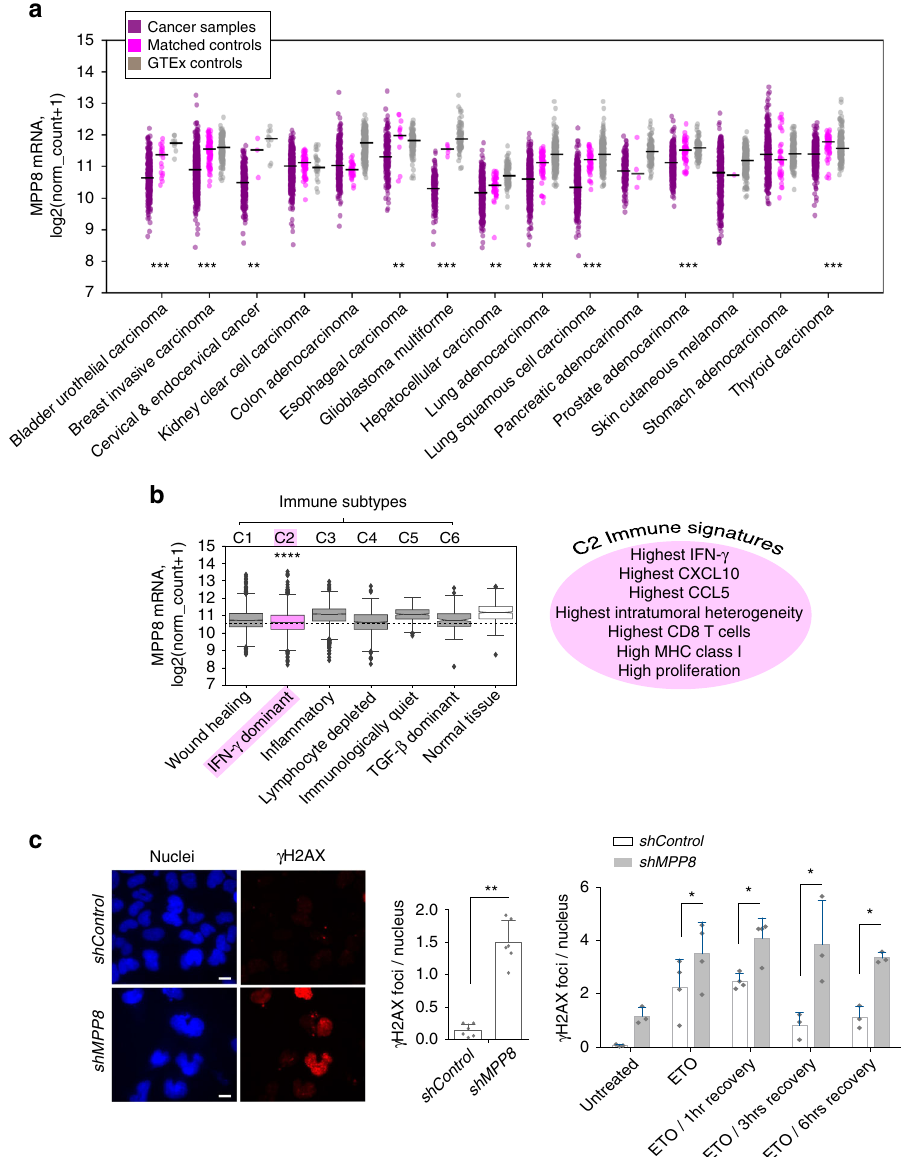
Fig. 6 MPP8 is frequently downregulated in cancers. a Using The Cancer Genome Atlas (TCGA) data, we selected cancers for which there were matched control samples as well as GTEx expression data from the same tissue. MPP8 is scored here as signi fi cantly downregulated when levels are lower in the cancer compared to both controls separately, using a two-sided Mann – Whitney rank test and correcting for multiple testing ( p adjusted values were all <0.05 for groups marked with asterisks). Adjusted p values for matched control comparisons and GTEx comparisons respectively are given here: bladder urothelial = 2.40e − 05, 1.58e − 06; breast invasive = 5.40e − 35, 8.79e − 61; cervical & endocervica l = 3.12e − 03, 2.37e − 07; esophageal = 1.07e − 03, 4.0e − 15; glioblastoma = 2.10e − 08, 6.61e − 40; liver hepatocellular = 1.31e − 03, 5.57e − 31; lung adeno = 1.19e − 11, 9.56e − 82; lung squamous cell = 2.40e − 26, 1.41e − 97; prostate adeno = 2.06e − 11, 8.27e − 31; thyroid = 1.25e − 10, 9.24e − 17. b Left: all cancers were divided by immune subtype based on ref. 17 and levels of MPP8 expression were plotted. MPP8 levels were most signi fi cantly different in subtype C2 compared to normal tissue (after pairwise, two-sided t tests between each immune subtype and normal tissue with an fdr multiple test correction: padj = 8.03e − 94; C1 n = 2,066, C2 n = 2413, C3 n = 2334, C4 n = 1129, C5 n = 378, C6 n = 180 samples). Boxes represent 1st and 3rd quartile and the central line is the median. Notches indicate the con fi dence interval; whiskers correspond to 1.5 of the interquartile range and outliers are depicted as diamonds. Right: features of cancers within immune subtype C2 are displayed (terms from ref. 17 ). c 293 reporter cells were treated with shRNAs and then either untreated or treated with etoposide (ETO) for 30 min and allowed to recover for stated times before γ H2AX staining. Left: example γ H2AX staining images. Middle: summary data of γ H2AX foci: N = 6 biologically independent samples. p = 0.0013 (two-tailed paired t test). Right: summary data of recovery assay. N = 4 biologically independent samples, except for the groups, ETO and ETO/1 h, where N = 3. Two-tailed paired t test p values = 0.0303 (ETO) 0.0486 (ETO/1 h) 0.0384 (ETO/3 h) and 0.0258 (ETO/6 h). Data show the mean ± SD. See Supplementary Fig. 6e for HeLa